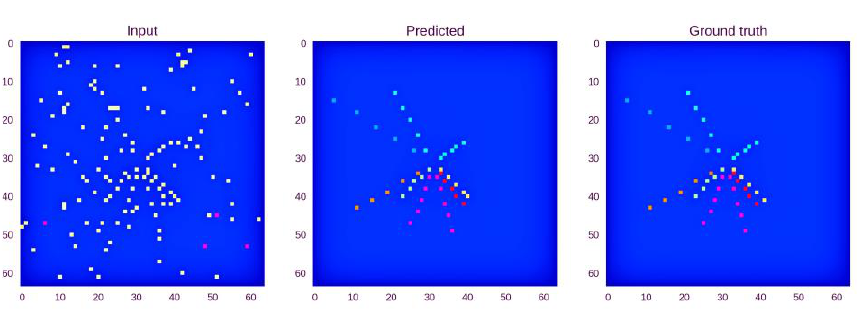
Fig. 3. Example of the model prediction. XoY plane of 3D event is shown. The left image is the LOOT input; the central image is the prediction and the right one – the